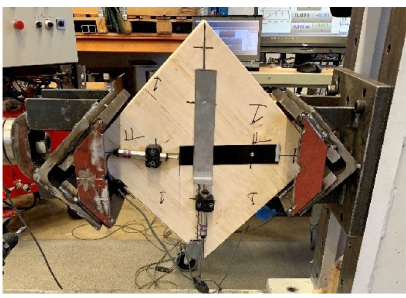
Fig. 4 Diagonal compression test with attached displacement transducers